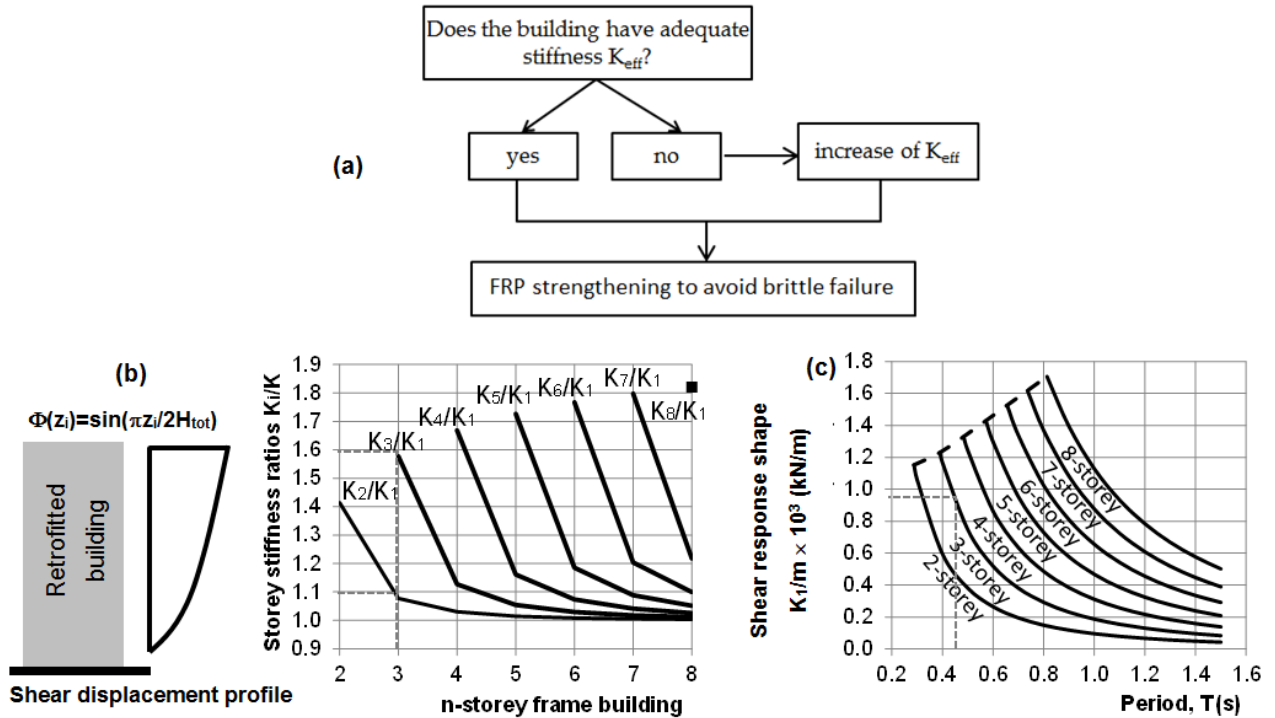
Figure 4. ( a ) Flowchart on the decision of implementing local and/or global interventions. For shear deflection shape ( b ) Storey stiffness ratios k i (= K i /K 1 ) and ( c ) corresponding stiffness to mass ratio for the first storey, K 1 /m 1 , versus period (note to obtain required K 1 values multiply the ordinate by the mass m, in tons).